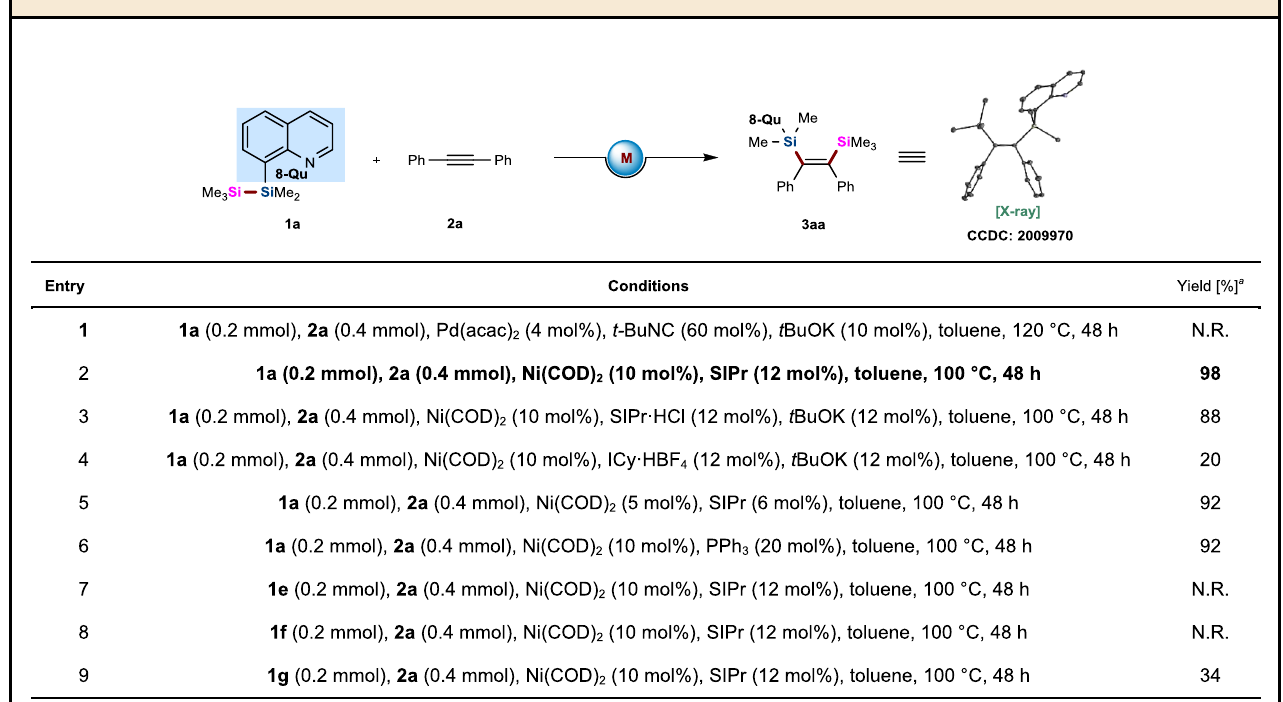
Table 1 Control experiments for the screening of reaction